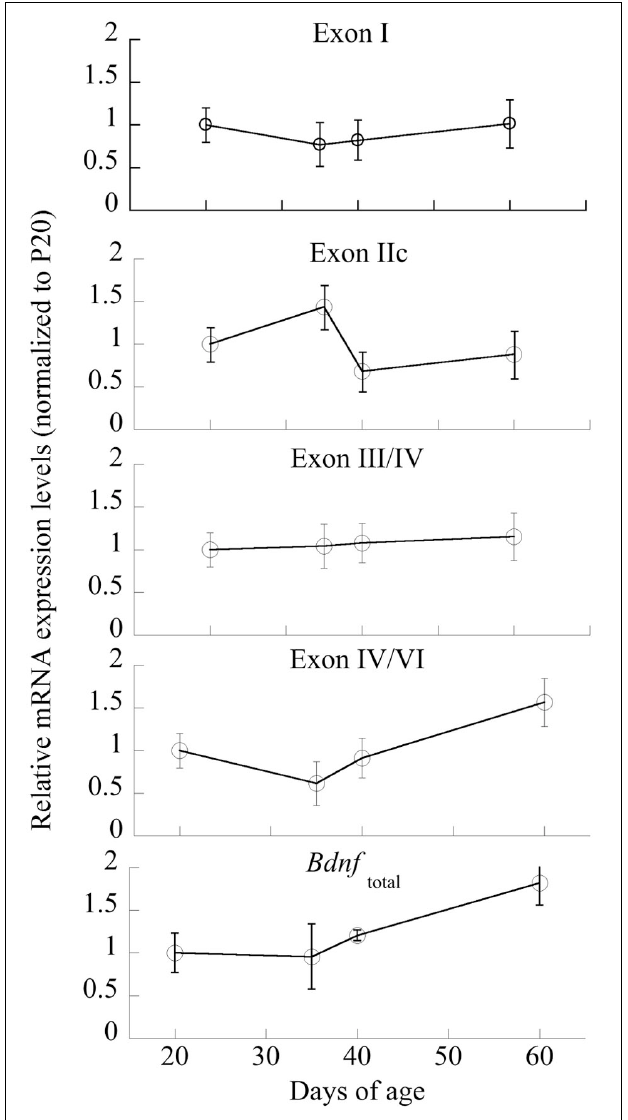
FIGURE 4 | The effects of juvenile treatment with Veh, MPH, the D3R antagonist nafadotride or MPH in combination with nafadotride on Bdnf mRNA levels in the PFC following place conditioning. Means ± SE are presented for n = 7–8 subjects/condition. ∗ indicates significant difference at p < 0 . 05.